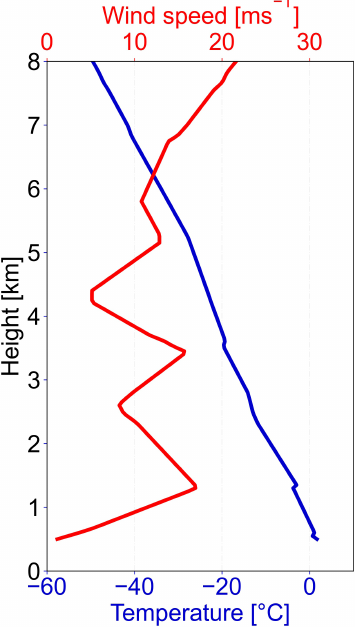
Figure 4. Temperature and wind speed data from the Ober- schleißheim sounding station (about 13km north of Munich, source: Deutscher Wetterdienst, data provided by University of Wyoming; http://weather.uwyo.edu/upperair/sounding.html, last access: 8 April 2022) at 12:00UTC are